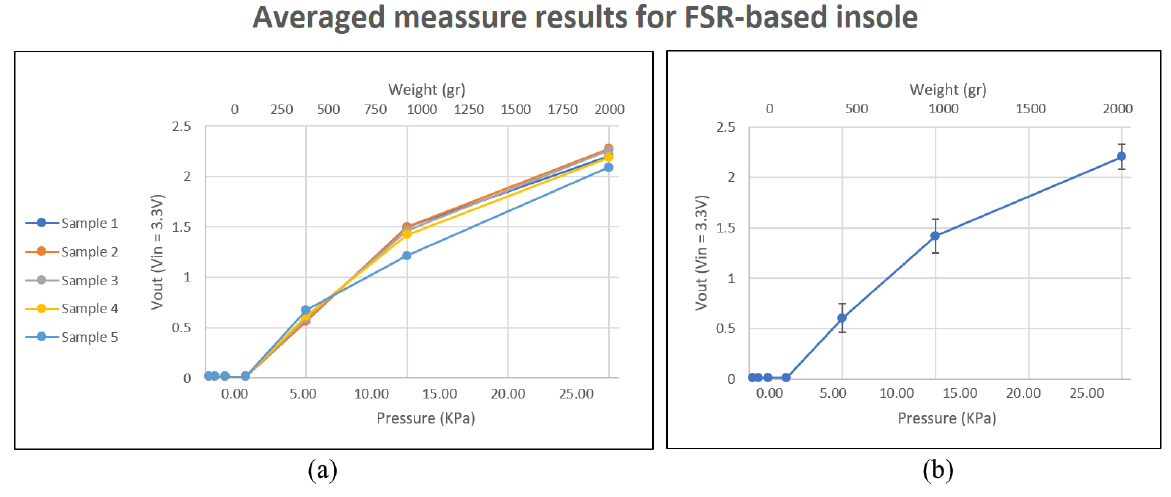
Figure 7. Resistive plantar insole. Behavior of sensors against weight in the area they occupy. ( a ) show the average results for each repetition performed. ( b ) shows the combined average of all